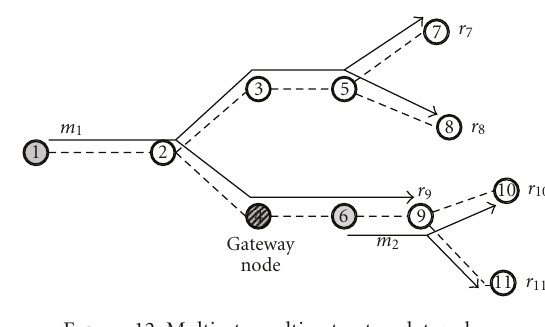
Figure 12: Multirate multicast network topology.